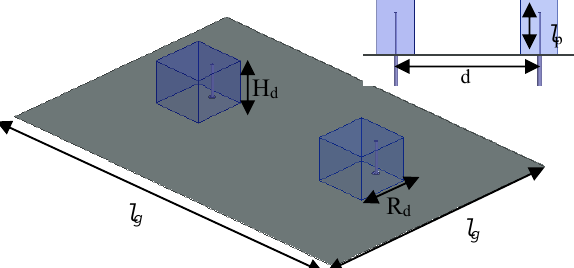
Figure 3: Geometry of the two elements of SDRA antenna array.